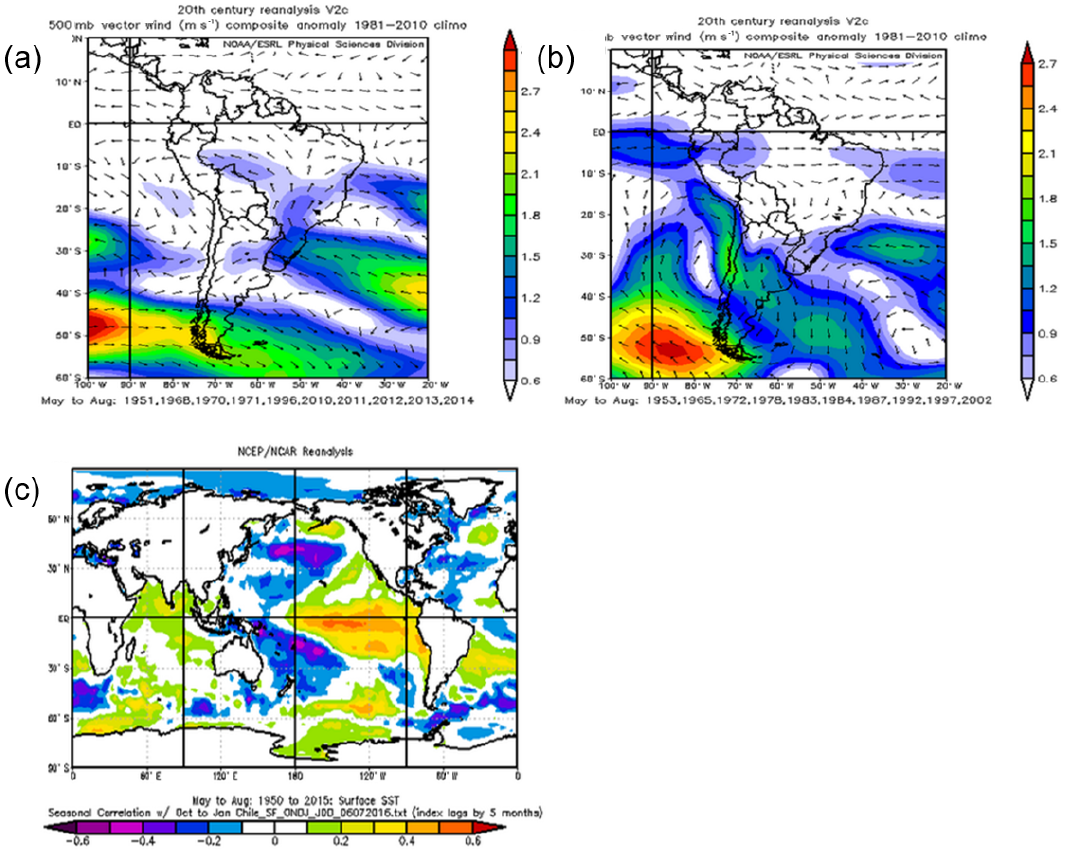
Figure 4. (a) Composite May–August (MJJA) vector wind anomaly preceding 10 lowest October–January (ONDJ) streamflow years. Panel (b) is the same as (a) for 10 highest ONDJ streamflow years; panel (c) indicates the correlation of MJJA sea surface temperature anomaly with ONDJ streamflow (1950–2015).